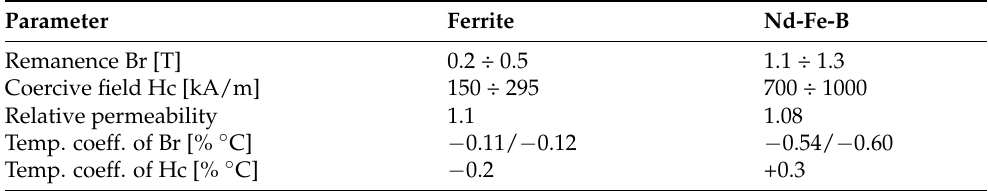
Table 1. Comparison among main parameters of ferrite and Nd-Fe-B magnets (Milanesi [33]).